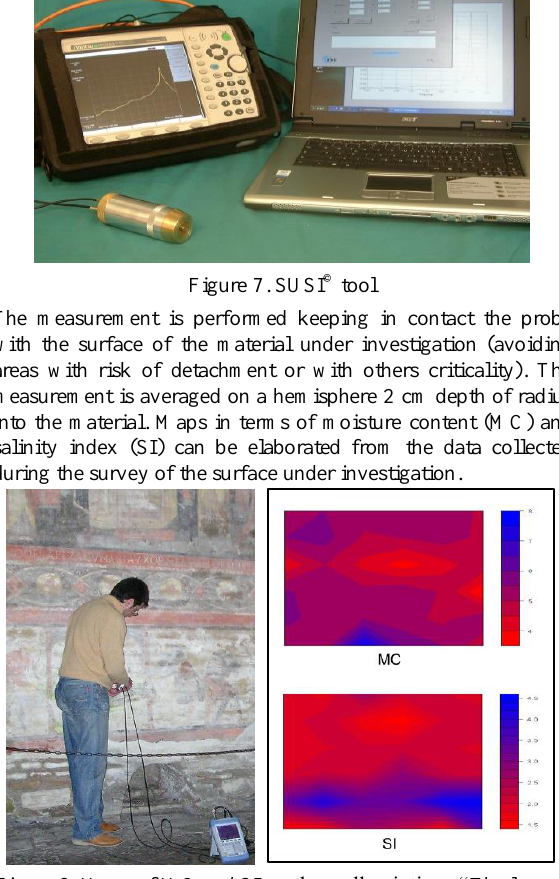
Figure 8. Maps of MC and SI on the wall paintings “The legend of St. Alex”, S. Clement church,